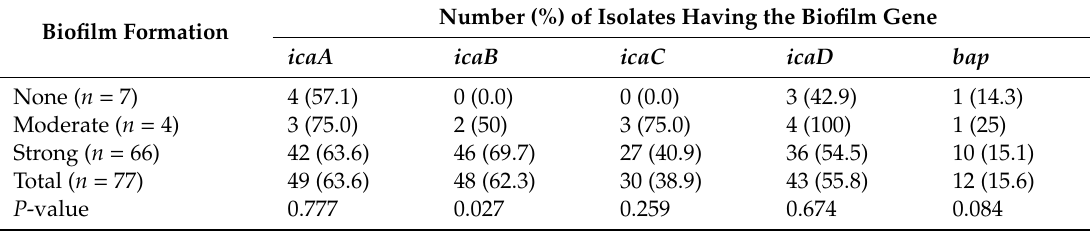
Table 2. Relationship between biofilm formation and biofilm genes in S. aureus isolates.